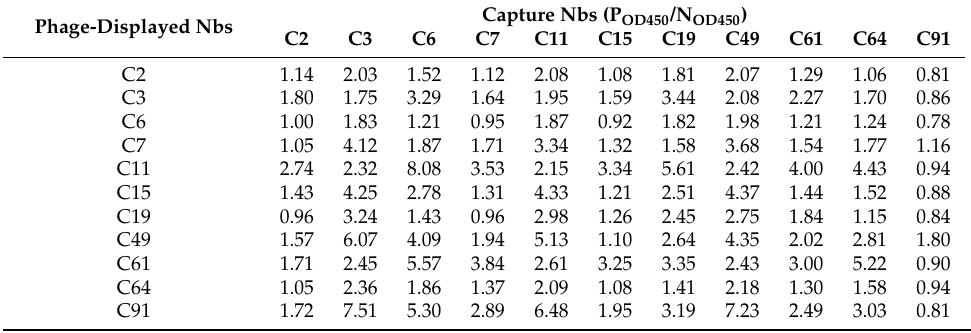
Table 1. Pairwise Study of Nanobodies against